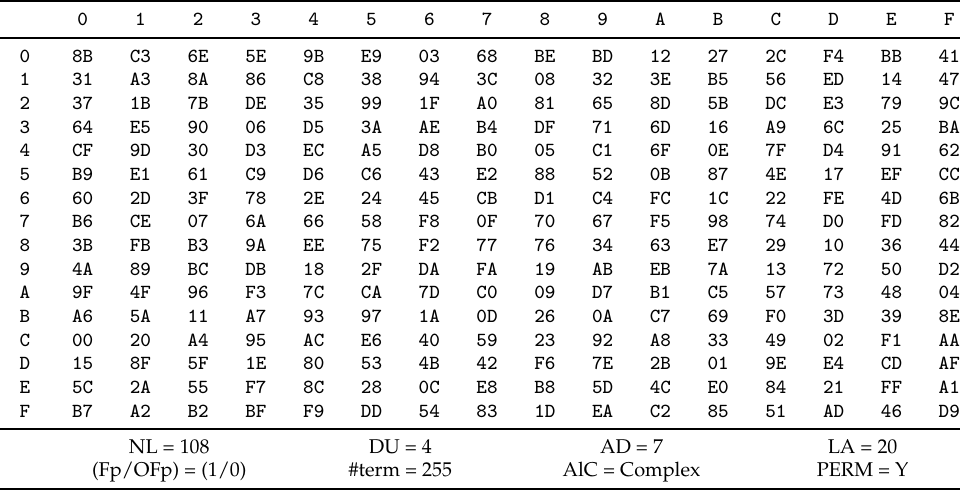
Table 7. Optimal S-box using Proposed